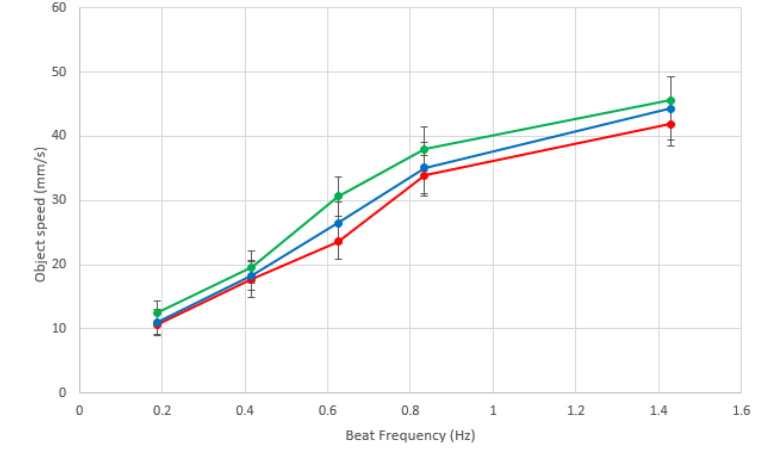
Figure 10. The effect of robotic cilia beat frequency on the speed of an object being moved across the surface. Each line is the same color as the object, illustrating red, blue and green